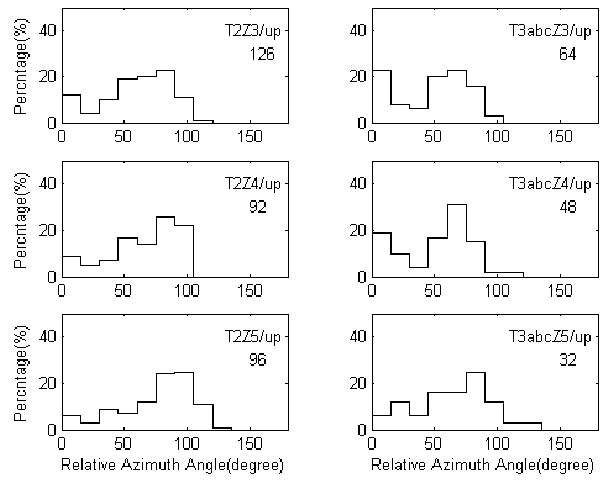
Fig. 13. Same as Fig. 2 except that the VB-period of 5min was Fig. 13 Same as Fig.2 except that the VB-period of 5 min was applied in this applied in this calculation. calculation.